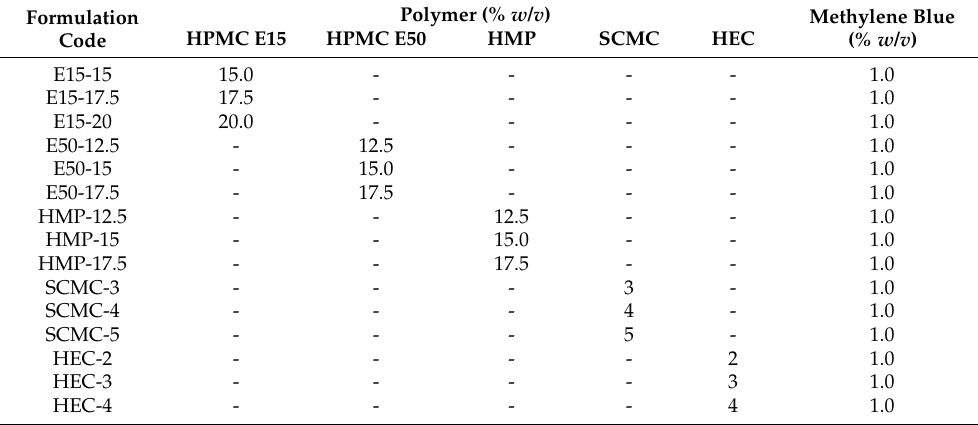
Table 1. Compositions of each printing gel. Formulation